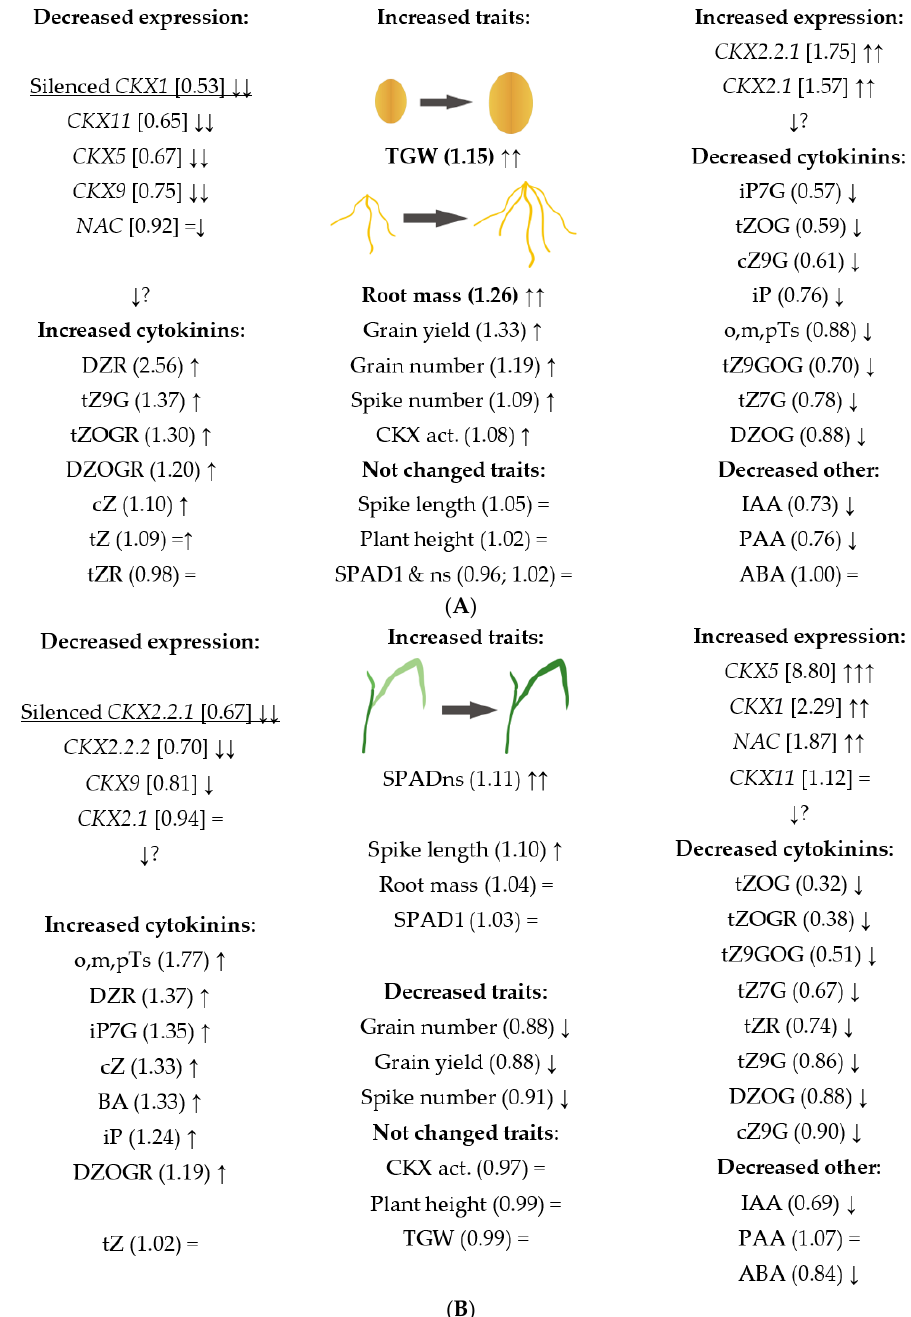
Figure 6. Schematic presentation of effect of TaCKX1 ( A ) and TaCKX2 ( B ) silencing on coregulation of expression of other TaCKX GFMs and phytohormone contents and yield-related traits. [ . . . ] relative expression to the control; ( . . . ) RI silenced or nonsilenced; ↑↑ , ↓↓ significantly increased, decreased; ↑ , ↓ increased, decreased